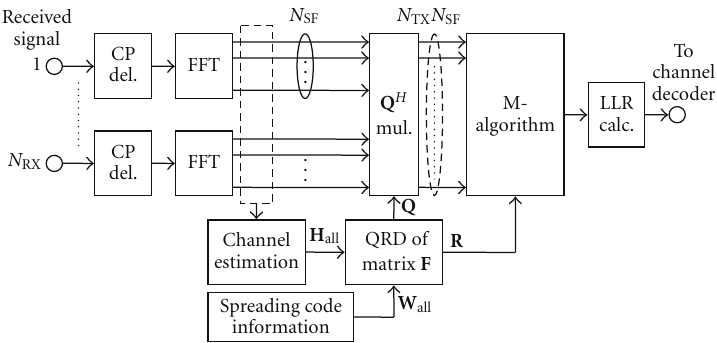
Figure 2: Block diagram of the proposed MLD-based signal